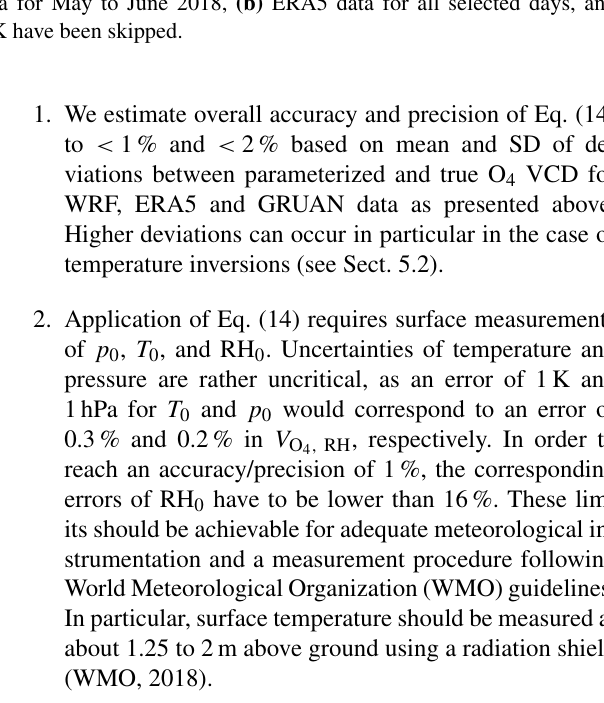
Figure 11. Dependency of δ RH on surface altitude for (a) WRF data for May to June 2018, (b) ERA5 data for all selected days, and